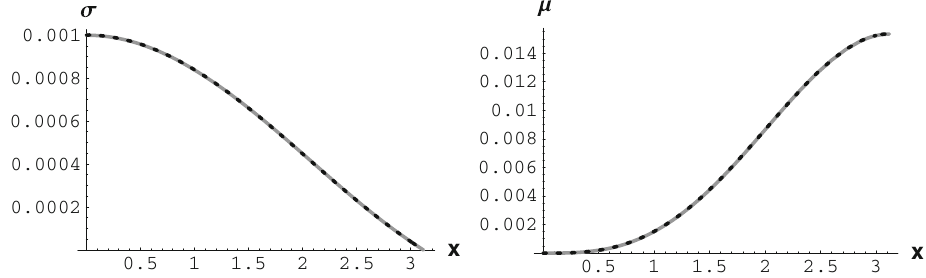
Fig. 2 Numerical solutions in the large coupling limit (dotted lines) and the present approximation (light solid lines) for σ( x ) and μ( x ) on the interval [ 0 ,π/ k ] , where g 2 = 0 . 1 and (cid:2) = 0 .